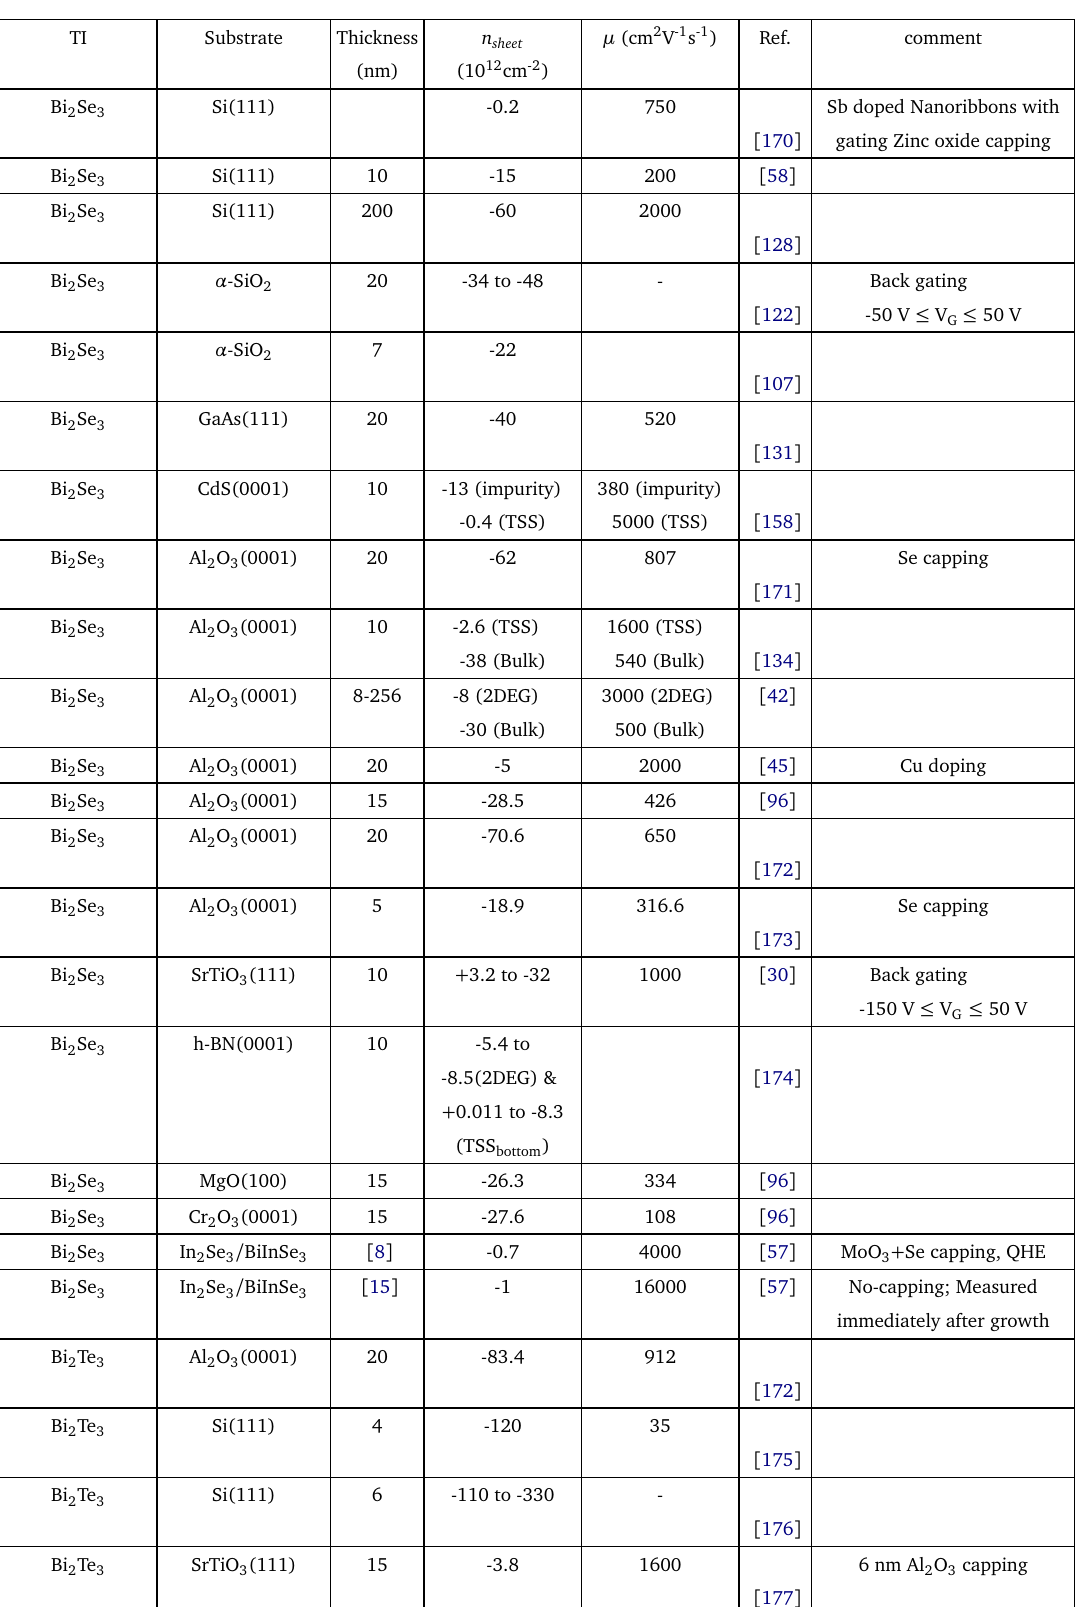
Table 1: DC transport properties of TI